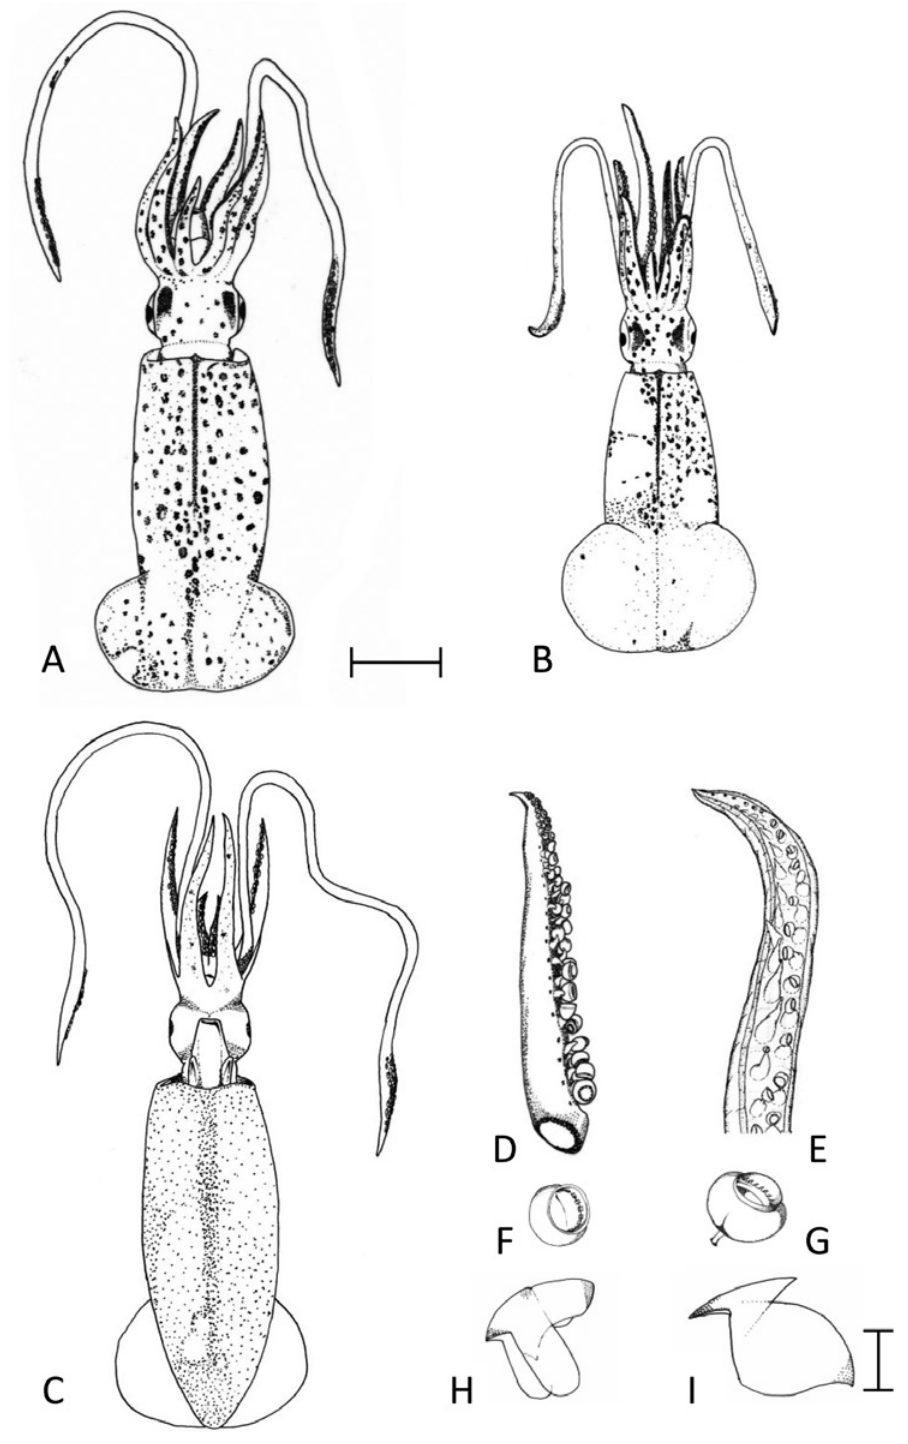
Figure 2 - Lolliguncula brevis of Brazilian coast. A- Female, dorsal view. B- Male, dorsal view. C- Female, ventral view (A, B, C: horizontal bar 10 mm). D- Second arm (mean length 16 mm). E- Hectocotylus (mean length 22 mm). F- Arm sucker (diameter between 0.1 and 1.2 mm). G- Sucker of the internal line of manus of tentacles (diameter between 0.3 and 2.5 mm); H- Lower beak; I- Upper beak (H, I: vertical bar 0.06